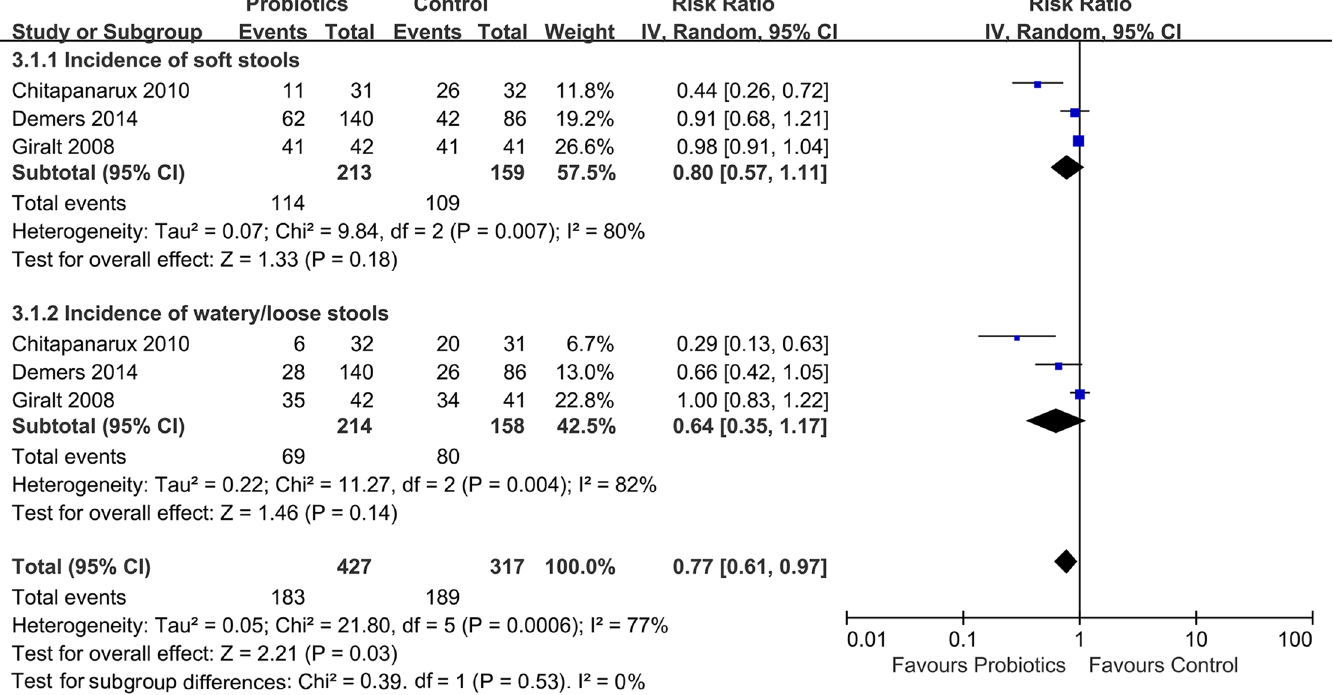
Fig 6. Effect of preventive probiotics on bristol scale on stool form compared with control treatment.